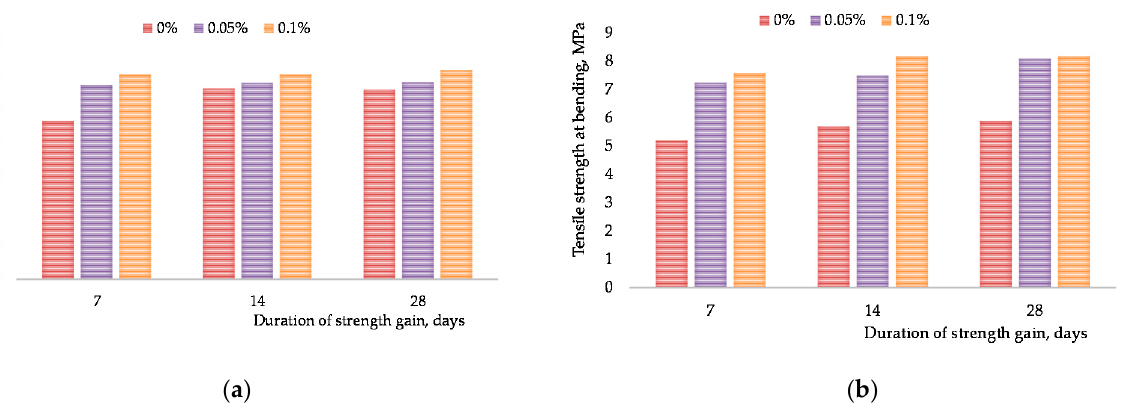
Figure 10 . Influence of the CNPLUS and Tensafor content on the strength characteristics of concrete grout: ( a ) ultimate compressive strength; ( b ) ultimate tensile strength at bending.